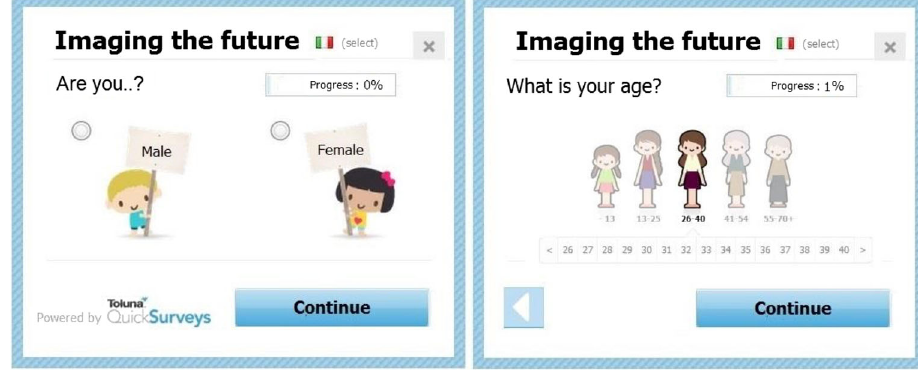
Fig. 1 Example of the online tool